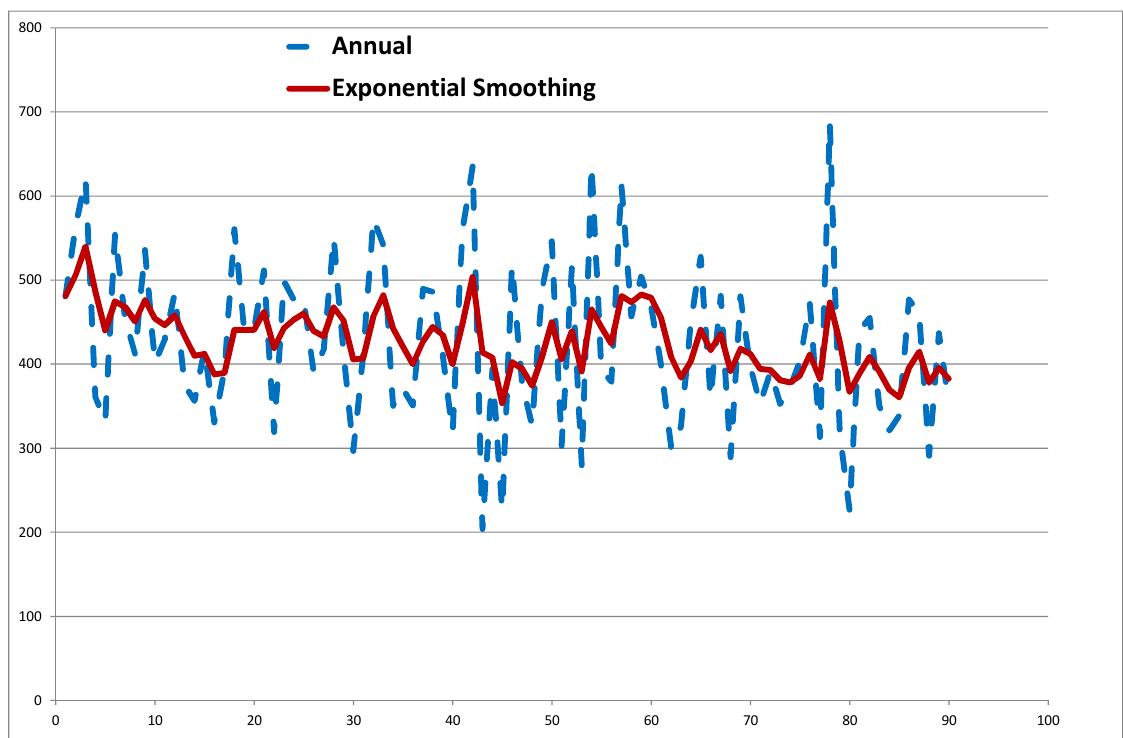
Figure 3. Annual rainfall totals for Cummins for 1945–2004 with smoothed